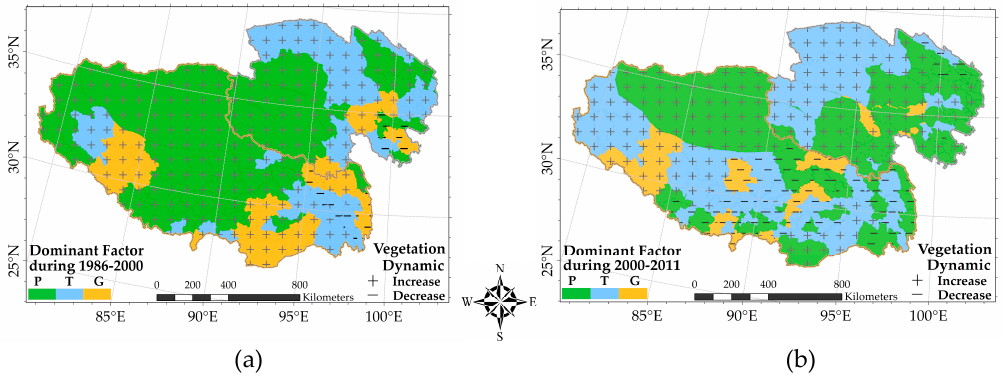
Figure 7. The dominant factors—the growing season temperature GST (T), the growing season precipitation GSP (P), and livestock grazing intensity LI (G)—driving variation in vegetation vigor across the Qinghai-Tibet Plateau during ( a ) the periods prior to 2000 and ( b ) the periods post 2000. The “+” indicates areas of decreasing trend in vegetation vigor; while the “ − “ represents areas of declining vegetation vigor.